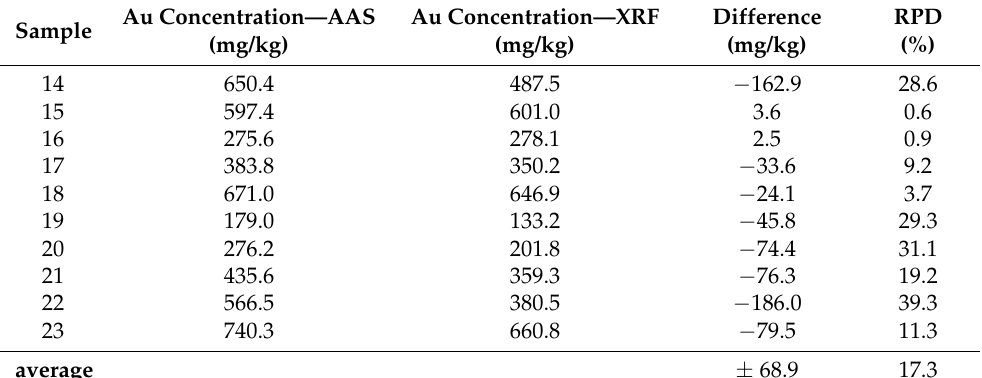
Table 3. Analysis of PCB samples: gold determination by XRF using the calibration curve and by AAS.